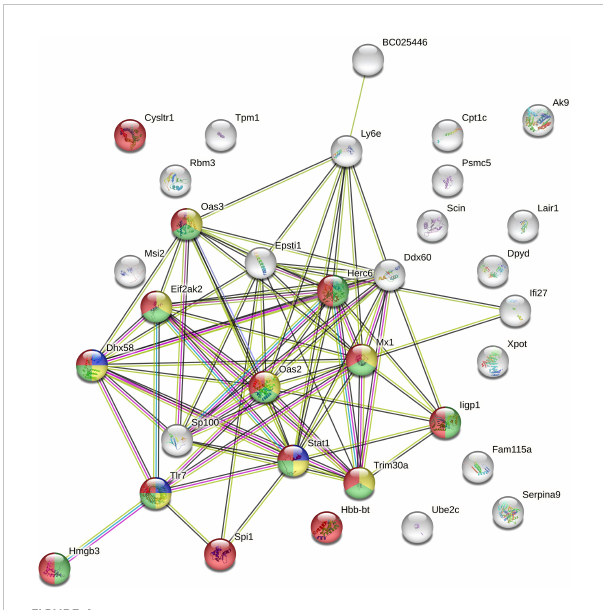
FIGURE 4 The protein-protein interaction network of down-regulated genes detected in Borreliella burgdorferi -infected Peromyscus leucopus mice. The protein-protein interaction analyses of 46 down- regulated genes identi fi ed in the spleen transcriptome of B burgdorferi -infected P. leucopus mice compared to their uninfected controls were performed using the STRING database. Colored are 14 proteins that are related to immune system process pathways (red), of which 11, 8, and 3 proteins are speci fi cally associated with innate immune response (green), viral defense response (yellow), and positive regulation of type I INF production (blue),